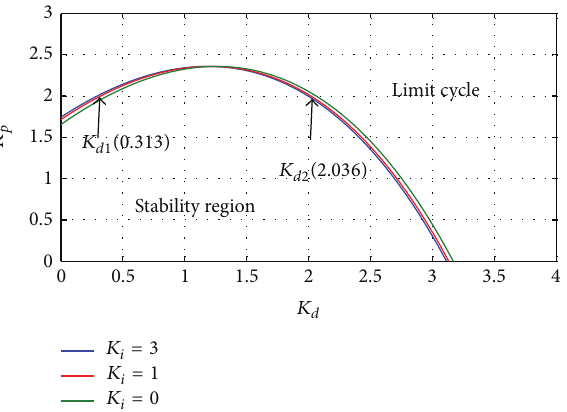
Figure 3: Curves of bifurcation points with 𝐾 𝑖 = 0, 1,3 .